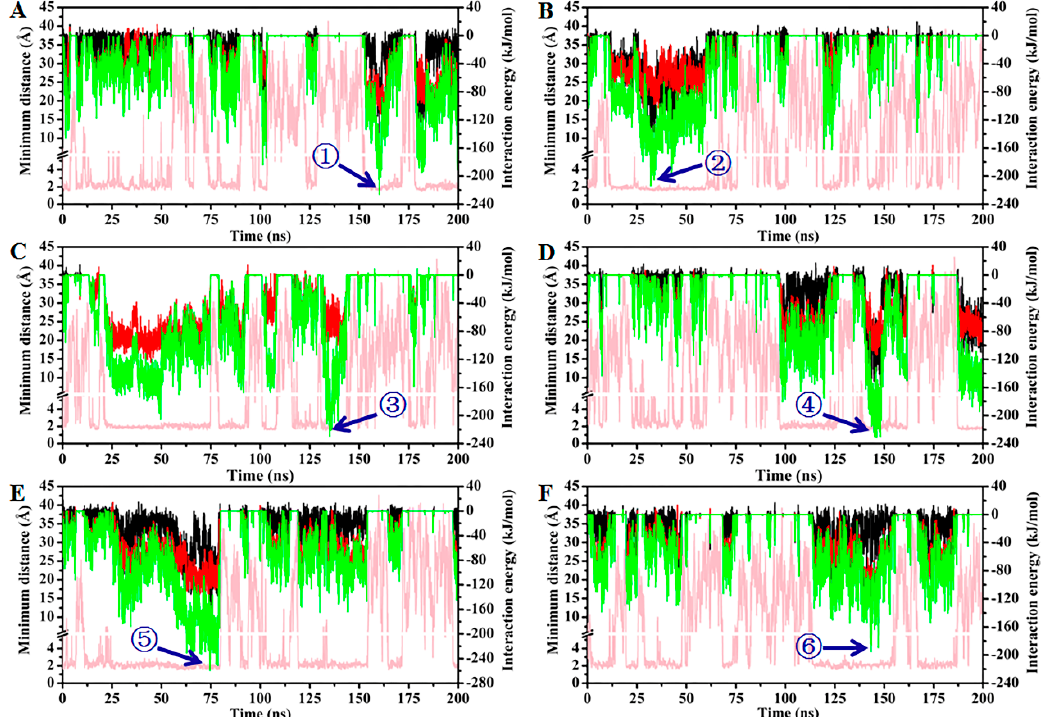
Figure 7. The computational results analysis ( A – F ) The minimum distances (pink line), vdW (black line), Coulomp (red line) and total (green line) interaction energy between ALA 1–6 and chitosan, respectively.